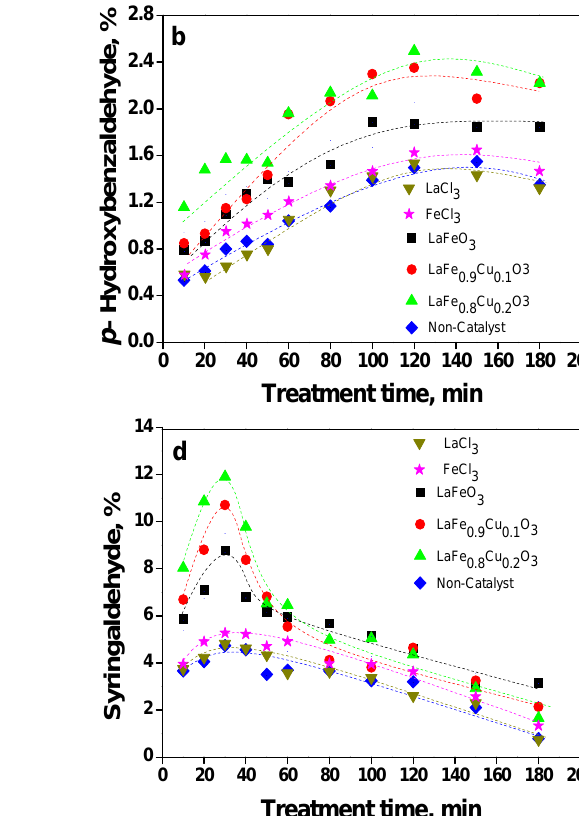
Figure 5. Lignin conversion (a), yield of p -hydroxybenzaldehyde (b), vanillaldehyde (c) and syringaldehyde (d) with reaction time (the reaction conditions were as follows: NaOH (2 mol/L), 120 °C, 5 bar partial pressure of oxygen in 20 bar total pressure, C =60.00 kg/m 3 , C =3 g/L and the lignin conversion=(C L0 catalyst initial concentration of lignin, and C is the concentration of lignin at any reaction t